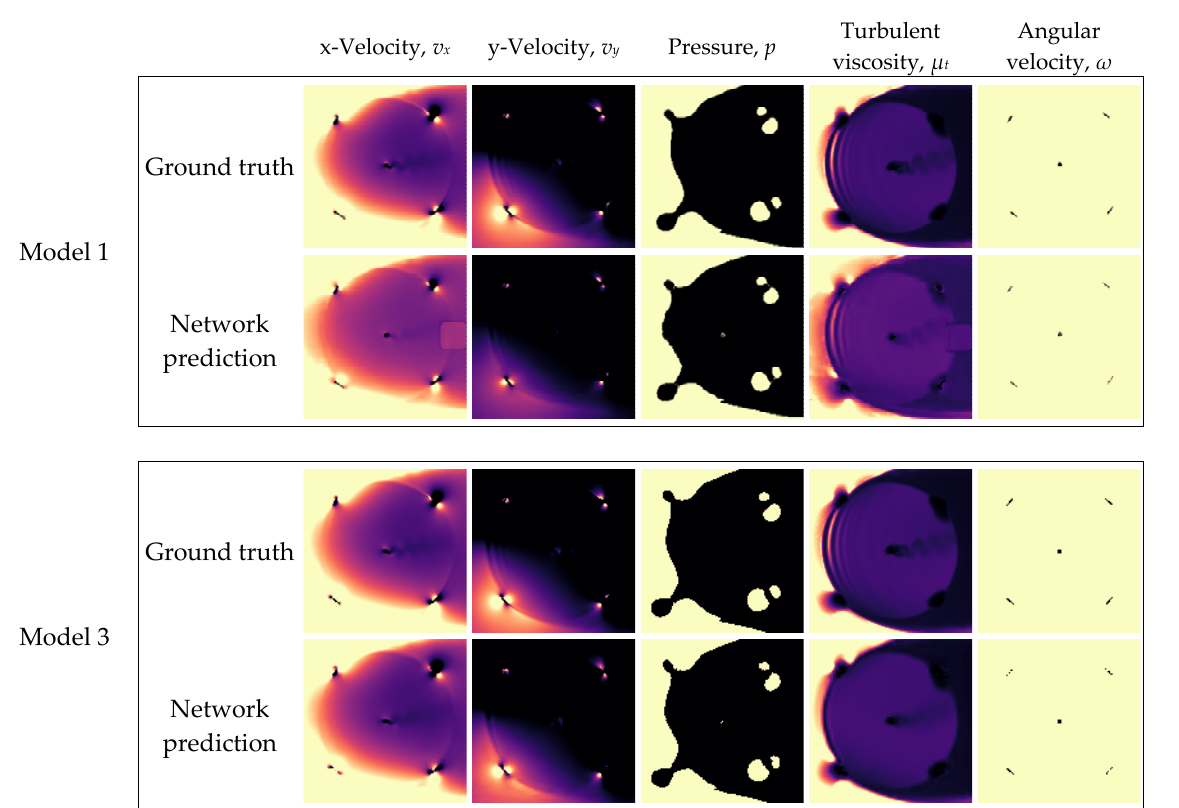
Figure 27. Ground truths and network predictions of Model 1 and Model 3, for the testing case of v ∞ = 2.0 m/s. v ∞ = 2.0